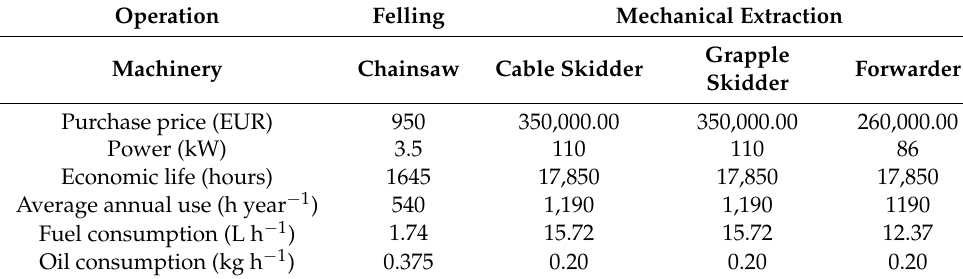
Table 3. Costs per logging scenario